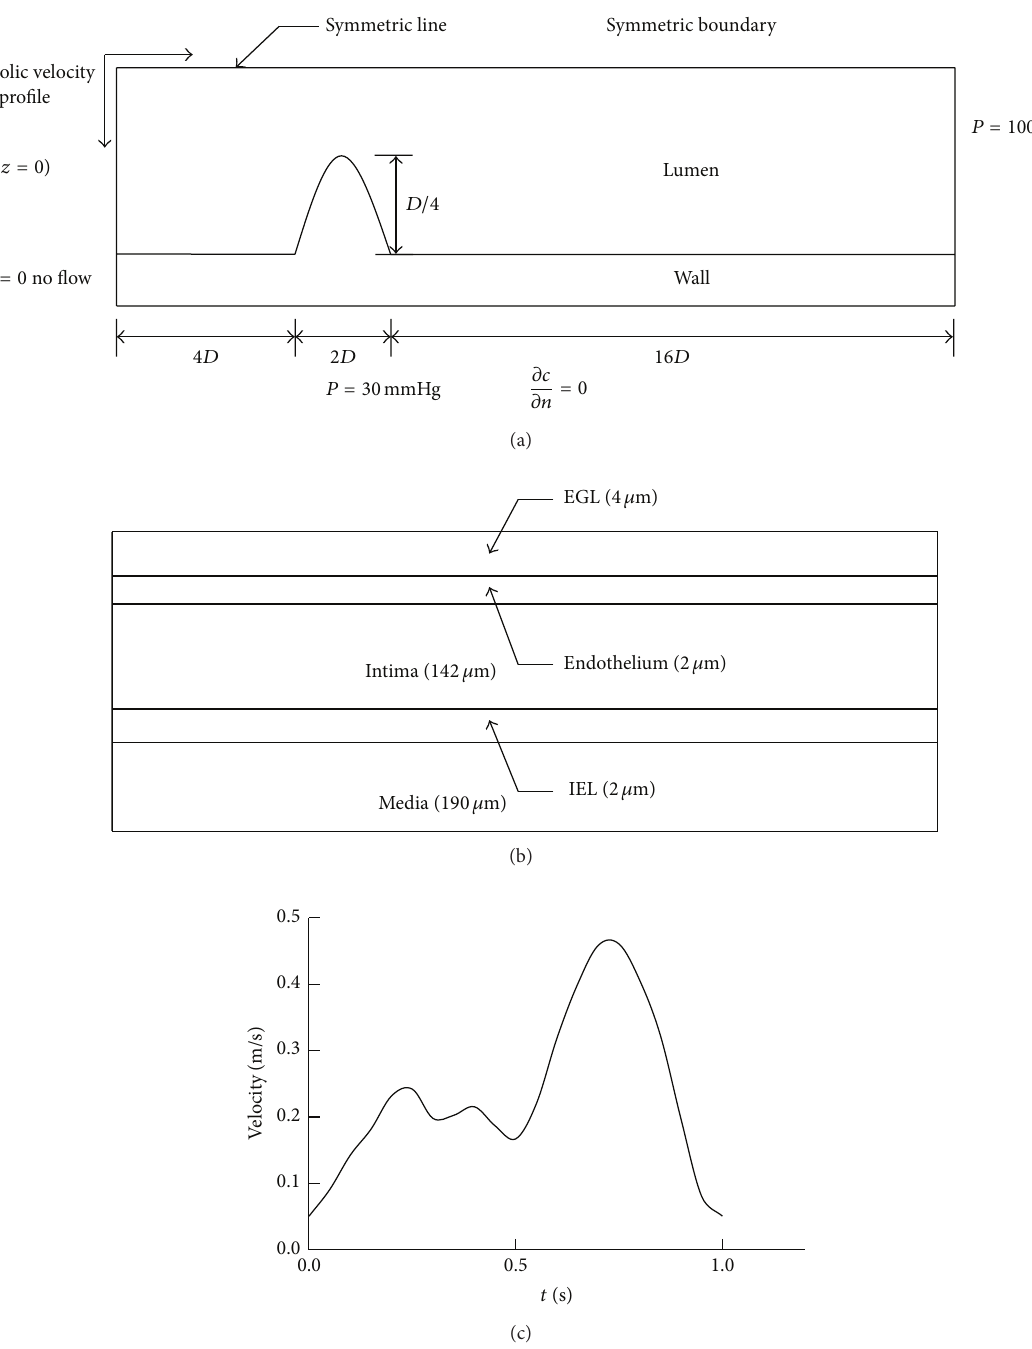
Figure 1: Schematic illustration of the computational geometry and boundary conditions. (a) The computational geometry of the stenosed model; (b)five-layer arterial wall with thethickness of each layer illustrated in theparentheses; (c) flowwaveform at theinlet. EGL: endothelial glycocalyx layer; IEL: internal elastic lamina; 𝐷 : inner diameter.